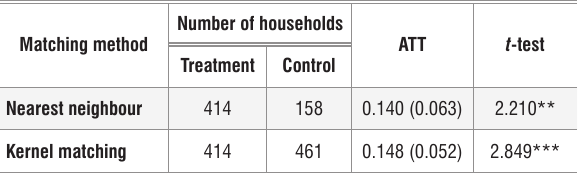
Matching method